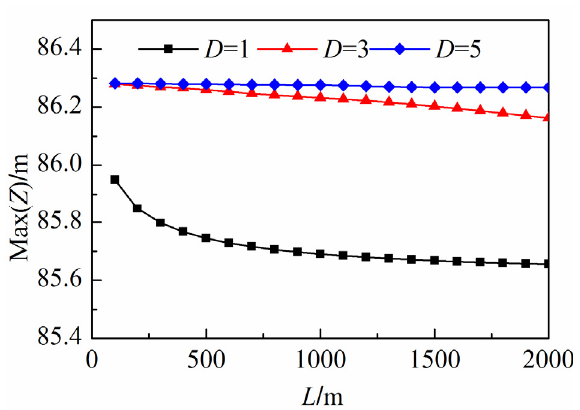
Figure 29. Effect of duct lengths and diameters on water level